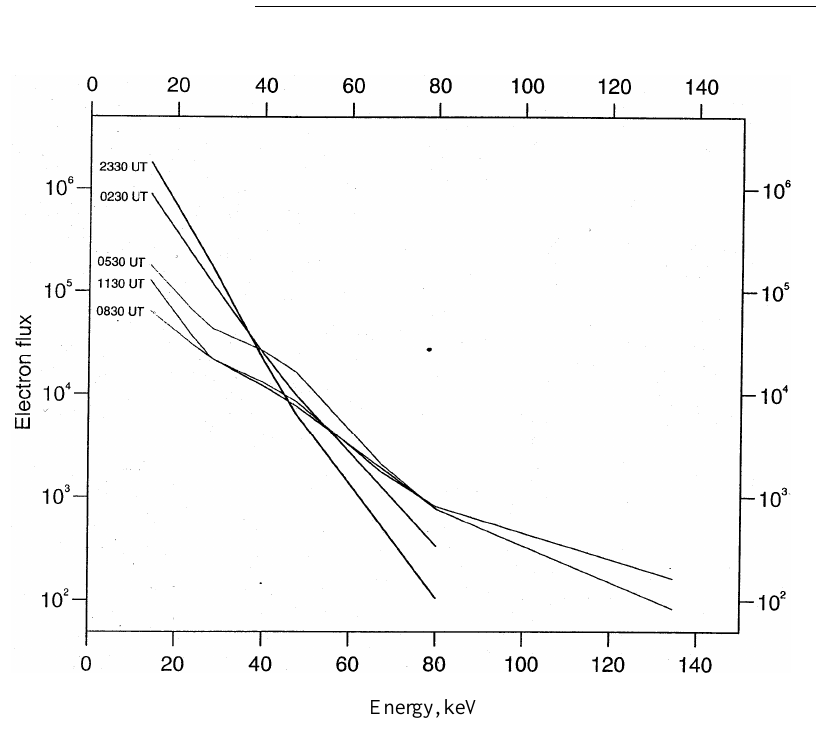
Fig. 5. Spectra deduced from the median electron-density profiles from night to